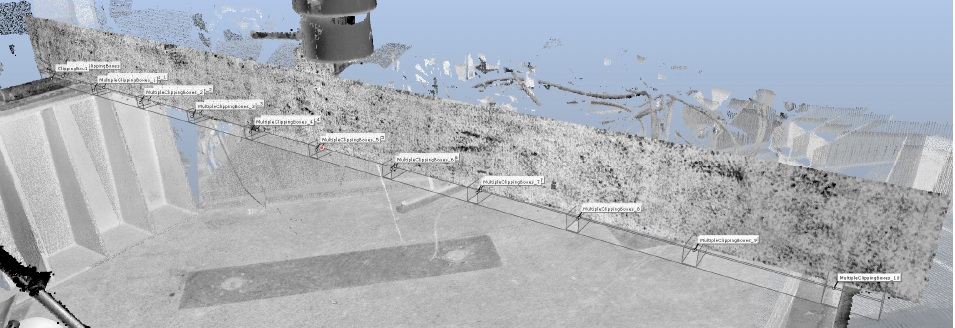
Figure 13. Arrangement of displacement measurement areas.